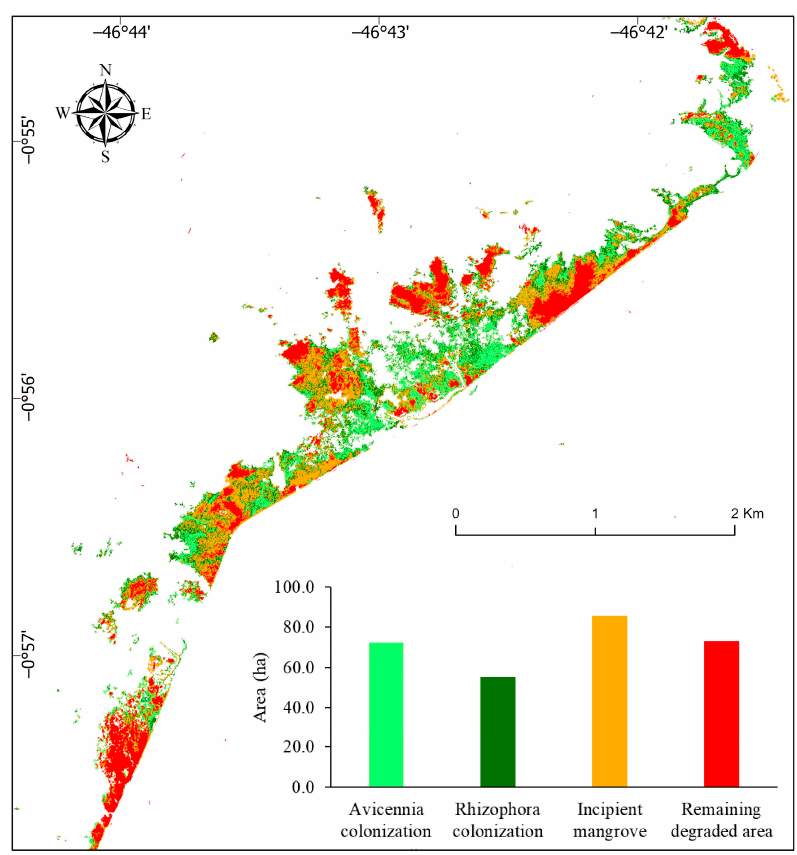
Figure 11. Changes in the mangrove degraded area between 2003 and 2019 using high-resolution images.